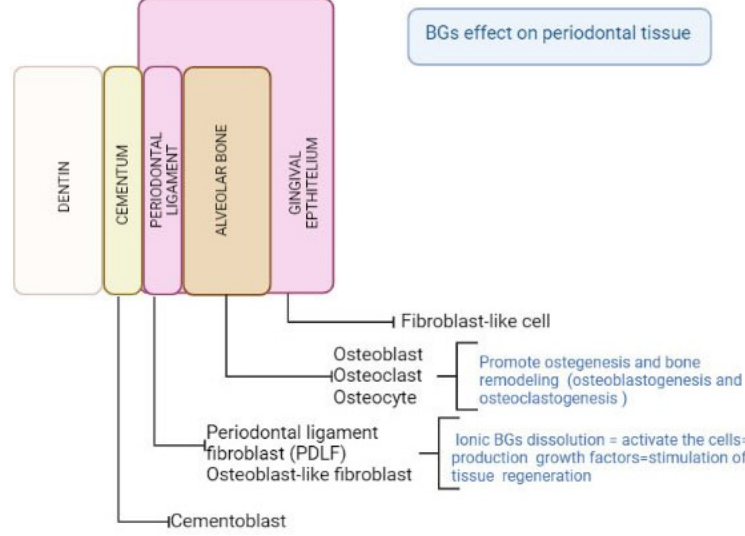
Figure 2. Schematic illustration of the BGs effect on periodontal